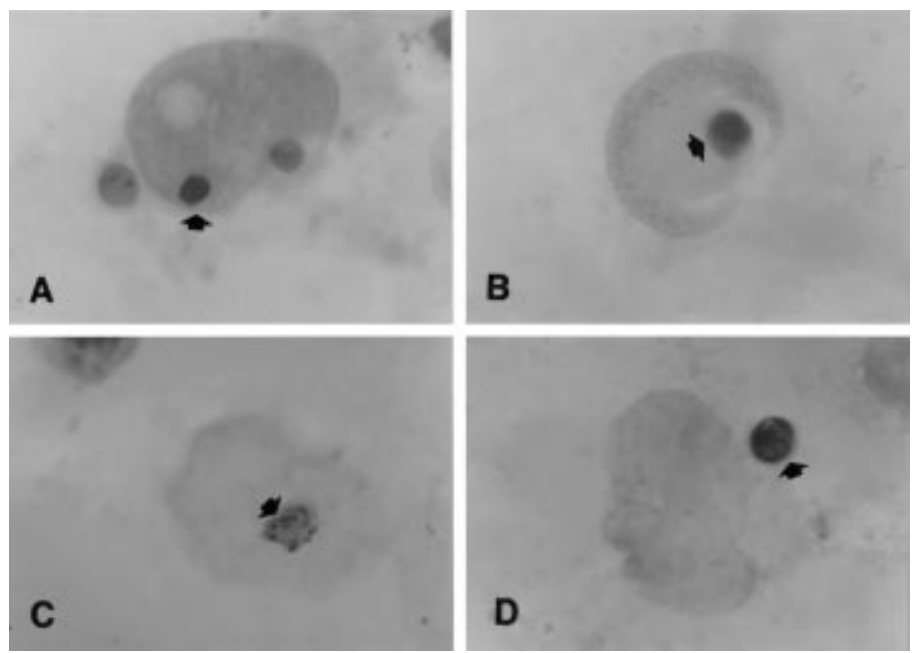
Fig. 4. Immunocytochemical staining of micronuclei for DNA strand breaks (blue colour) using TUNEL (A, B) and nick translation (C, D) method. A – outline of micronuclei shows strong TUNEL staining, while the micronuclei removed from the macronucleus are unstained. B – micronucleus show moderate staining with TUNEL method. C – the micronuclei outline shows weak staining by nick translation method. D – micronuclei removed from the macronucleus show strong staining by nick translation. Arrows point to micronuclei still associated with the macronucleus. DNA was counterstained by Feulgen procedure. Obj. 90 (cid:2) , oc. 7 (cid:2)